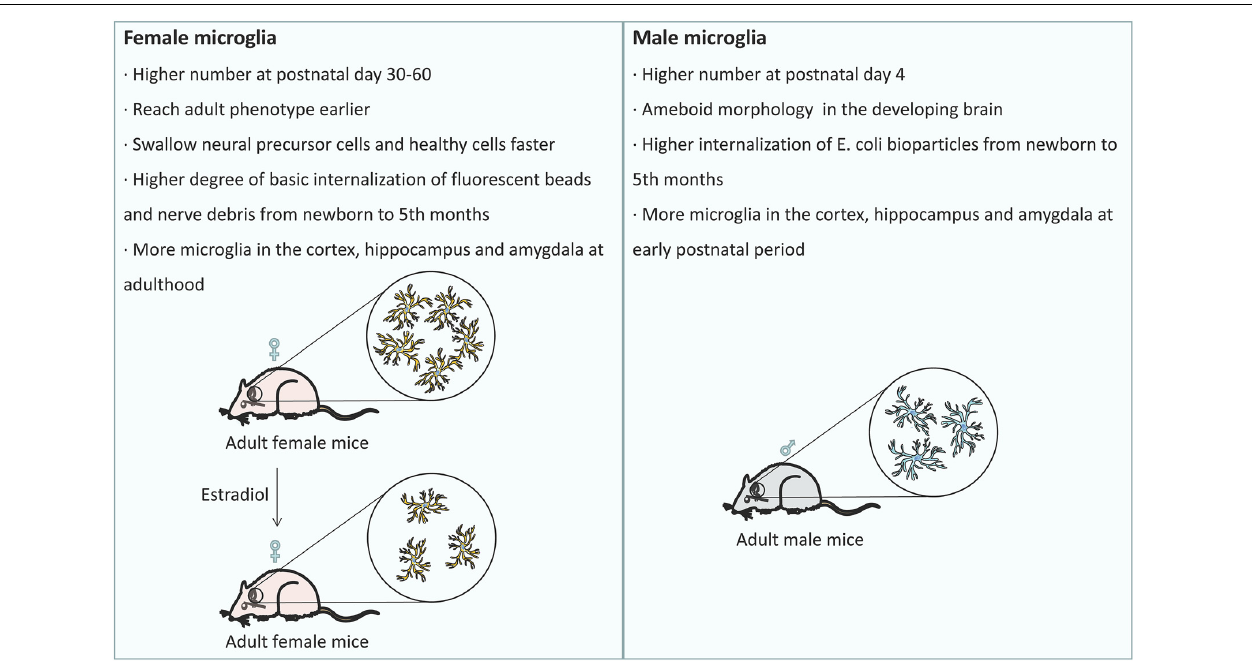
FIGURE 1 | Sex differences in the development of microglia: the differences in the number of microglia and their distribution among the brain regions at different developmental stages are related to sex. Females exhibit a higher rate of phagocytosis of neural precursor cells and healthy cells than males, and females have more phagocytic microglia than males. After treatment with estradiol, the number of phagocytic microglia in female mice decreased to the typical level observed in male